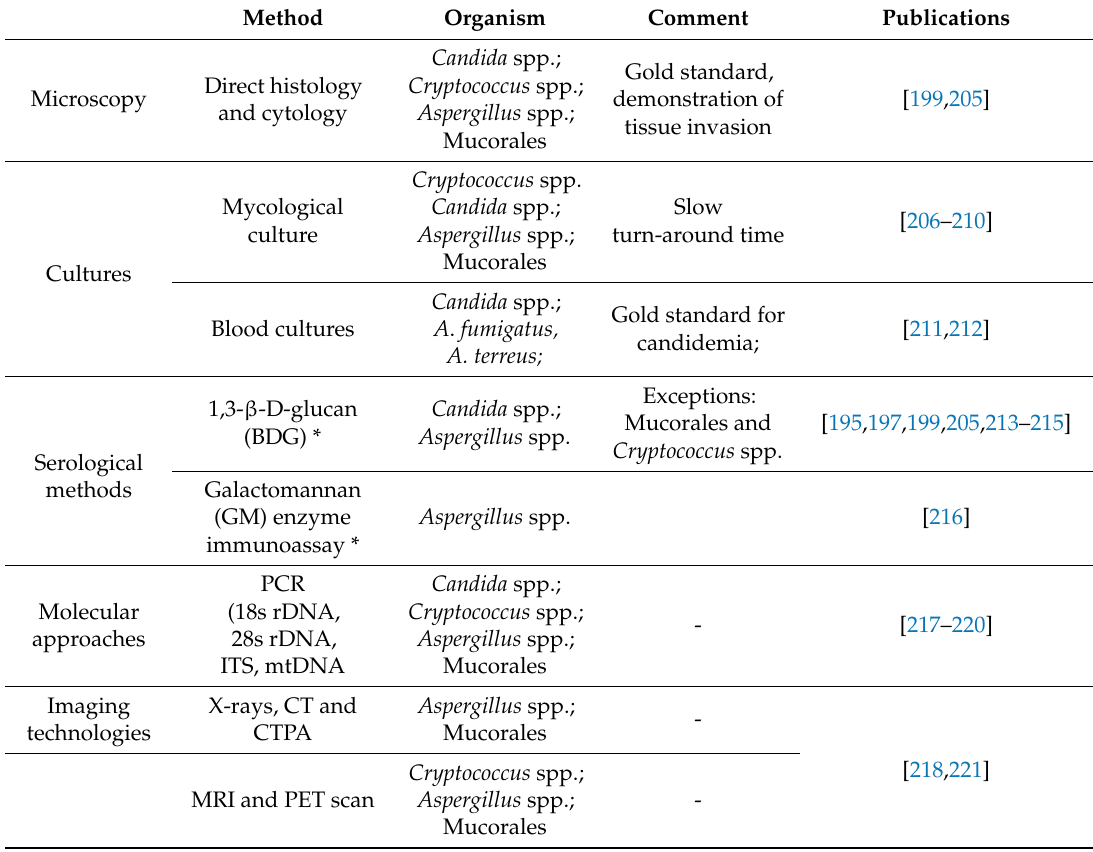
Table 3. Techniques used for diagnosis of fungal